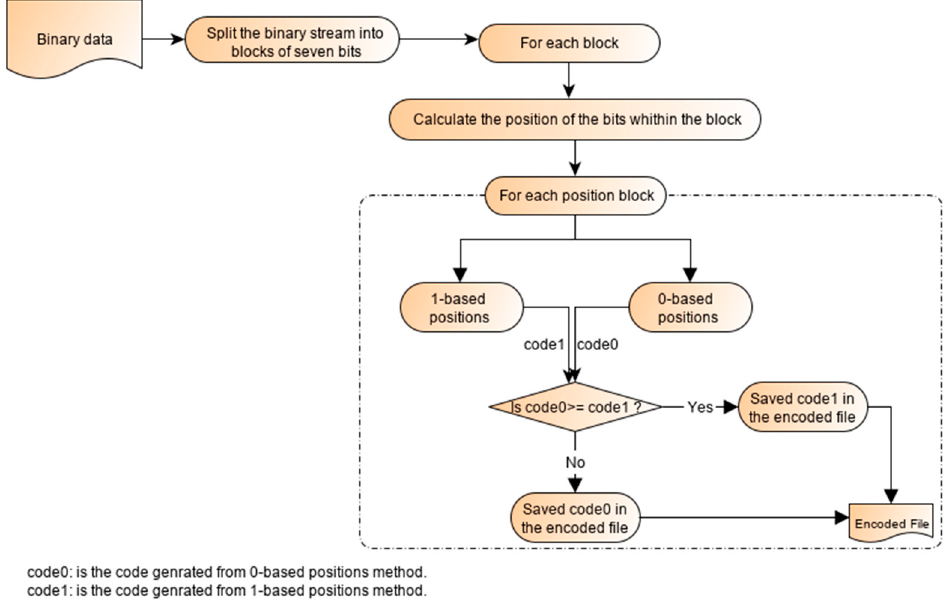
Figure 2. The encoding process of the single-block encoding algorithm.